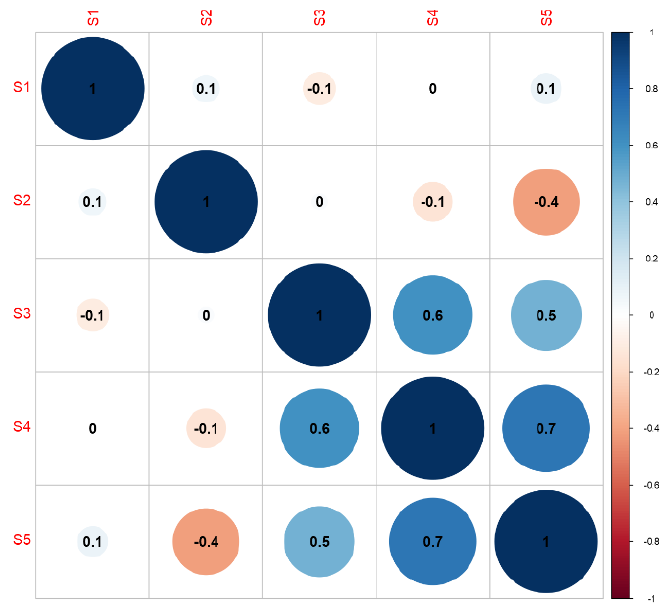
Figure 3. Matrix of correlation of energy consumption in technological processes for broccoli processing.